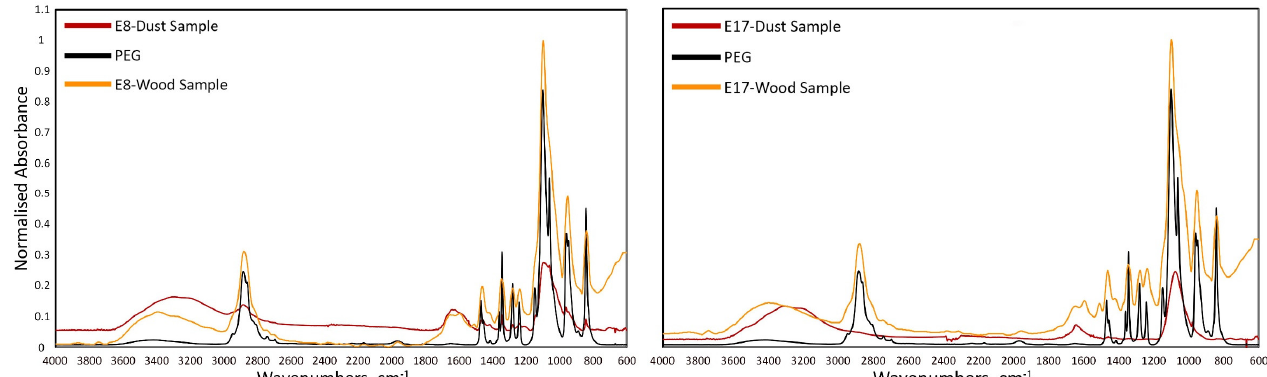
Figure 3 . FTIR spectra collected for the E8 and E17 dust samples, PEG, and archaeological wood samples.